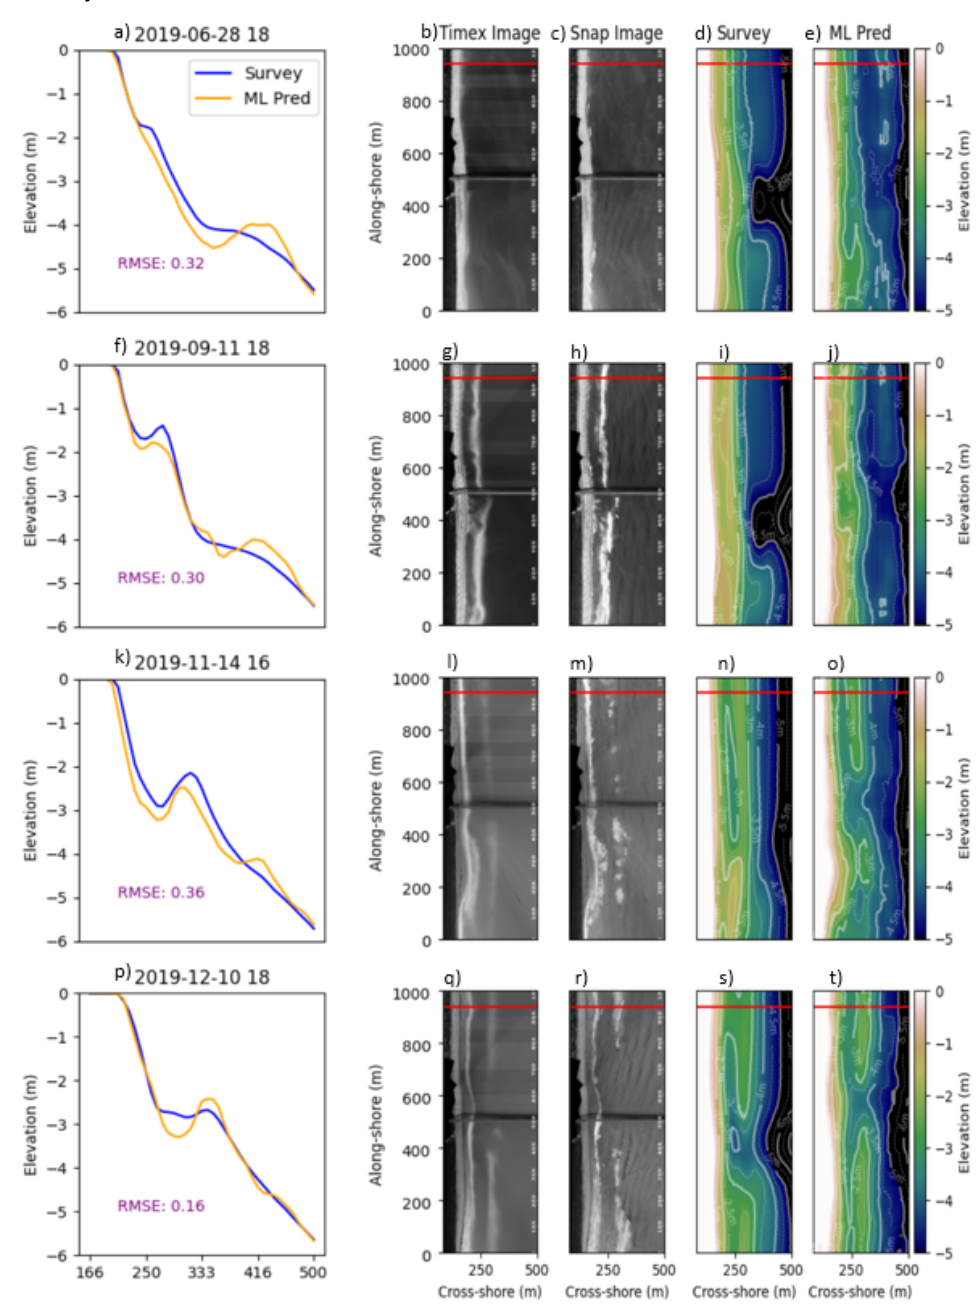
Figure 5. Example model results for the four dates in the second half of 2019. ( a – t ) show the same information described in Figure 4 for the shown